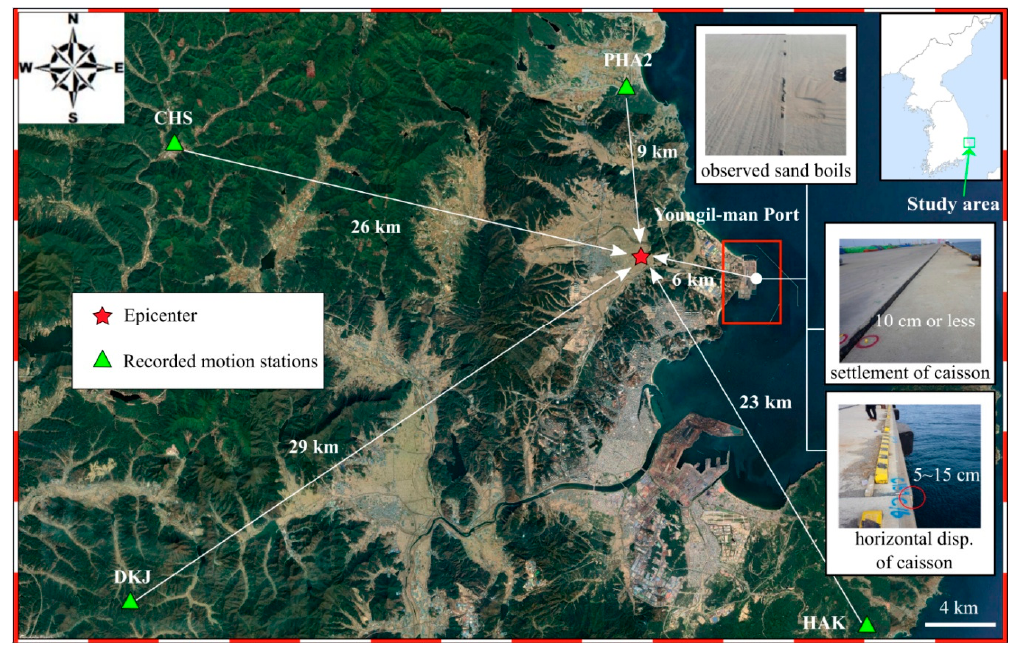
Figure 10. Locations of the Youngil-man port, liquefaction observations, and seismic motion recording stations relative to the epicenter of the 2017 Pohang earthquake. Table 2. Information of the four recording stations.